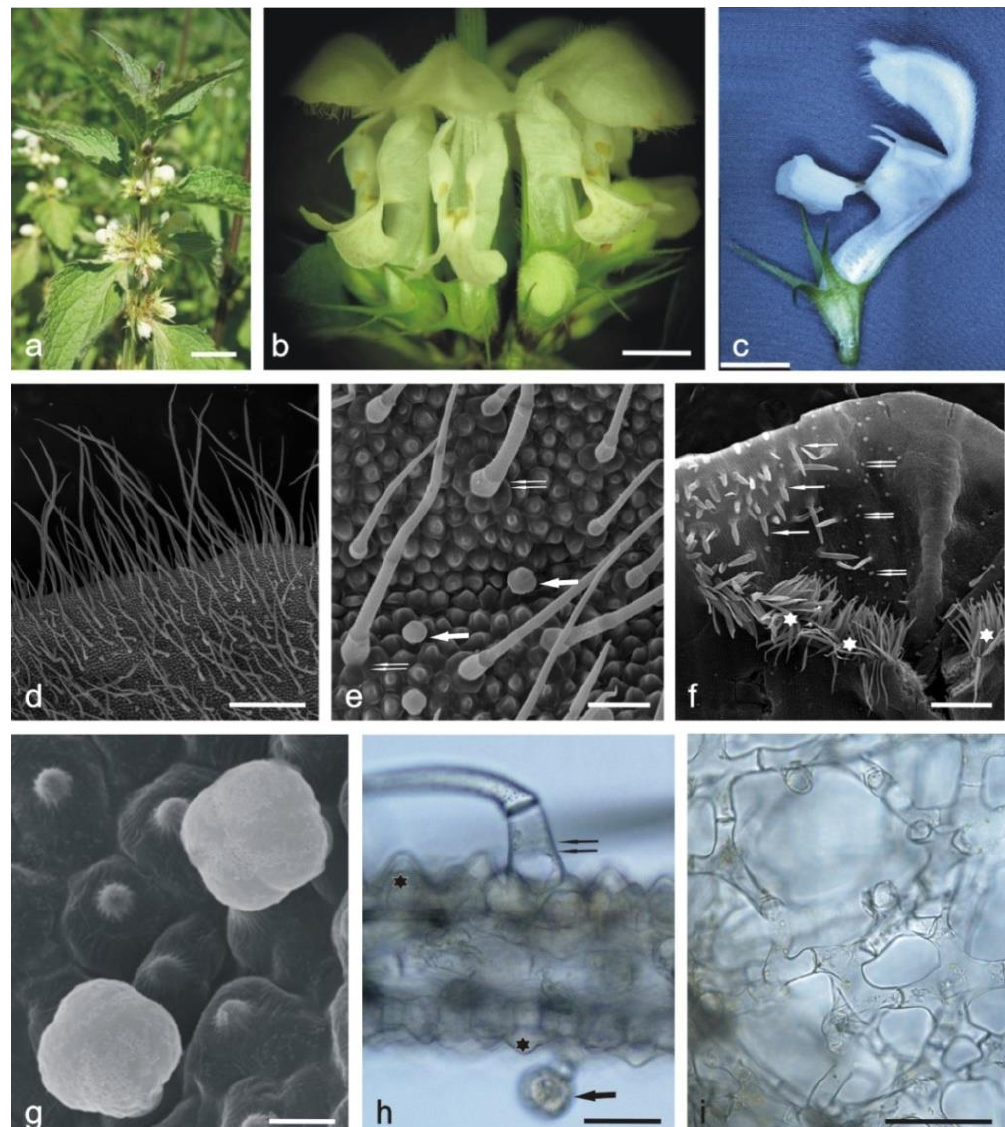
Figure 1. Lamium album subsp. album flowers and fragments of the corolla. c —stereoscopic microscopy (SM), ( d – g )— scanning electron microscopy (SEM), ( h , i )—light microscopy (LM). ( a ) Blooming plants. ( b ) Fragment of an inflorescence. ( c ) Lateral view of the flower. ( d ) Margin of the upper lip with long non-glandular trichomes. ( e ) Various types of trichomes and papillae on the abaxial surface of the upper lip: glandular trichomes (arrows), non-glandular trichomes (double arrows). ( f ) Fragment of the adaxial surface of the corolla tube with unevenly distributed non-glandular conical trichomes (double arrows), glandular trichomes (arrows) and a ring of flattened non-glandular trichomes (stars) located above the ovary. ( g ) Papillae and glandular trichomes with a 4-celled head on the adaxial surface of the upper lip. ( h ) Cross section of the upper lip with visible papillae (asterisks), glandular trichomes (arrow), and a non-glandular trichome (double arrow). ( i ) Loose arrangement of mesophyll cells in the cross section of the upper lip. Scale bars: 1 cm ( a ), 5 mm ( b ), 4 mm ( c ), 500 µm ( d , f , i ), 100 µm ( e ), 30 µm ( h ), 20 µm ( g ).